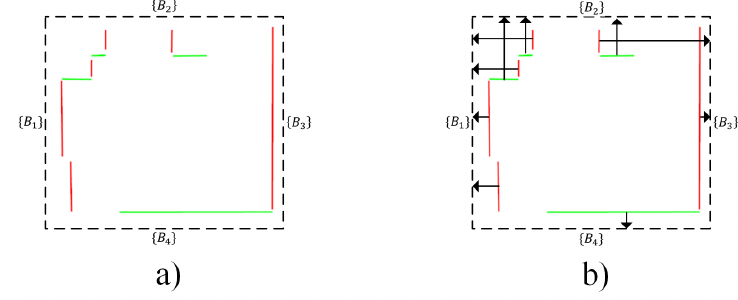
Figure 14. Initialization of the bounding box: Assigning linear primitives to the edges of bounding box (the arrows indicate the assigning directions): ( a ) illustrations of the bounding box, ( b ) the primitives assigned to the nearest edges of bounding